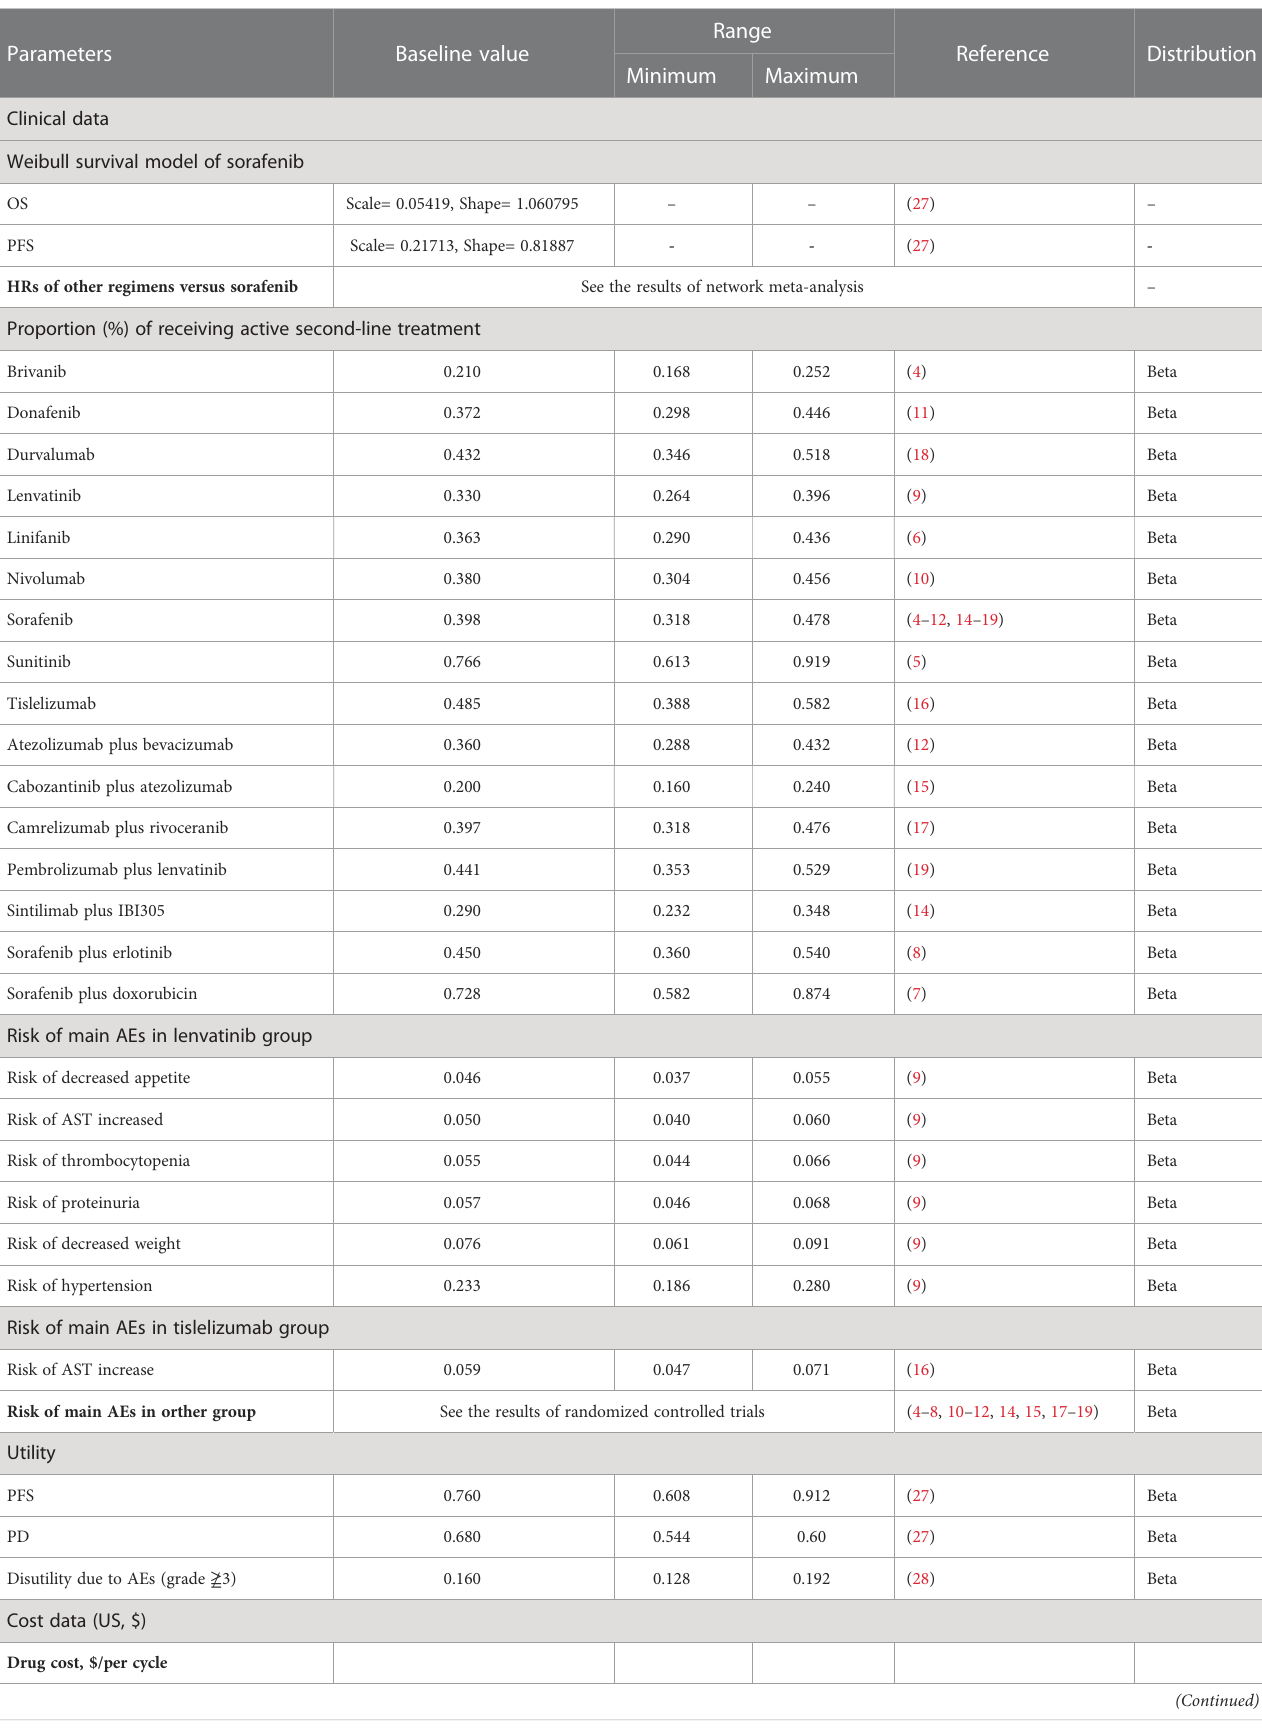
TABLE 1 Model Parameters: Clinical and Cost